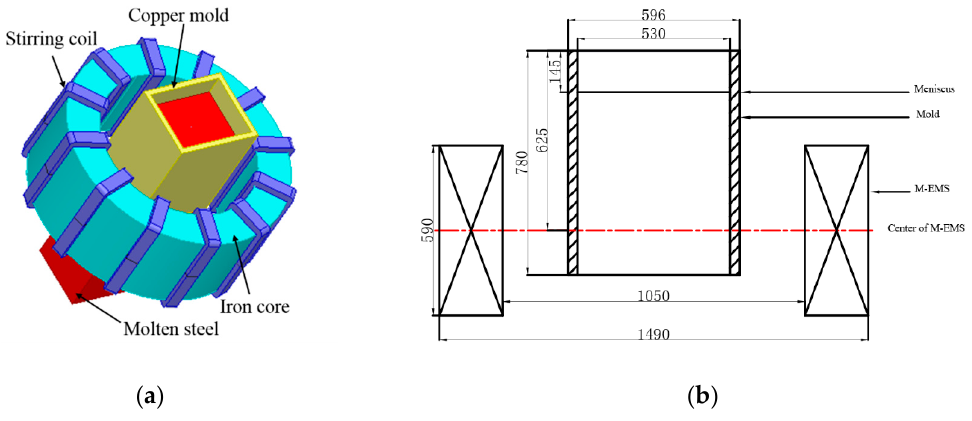
Figure 2. ( a ) Schematic diagram of M-EMS; ( b ) location of M-EMS, (Unit, mm).